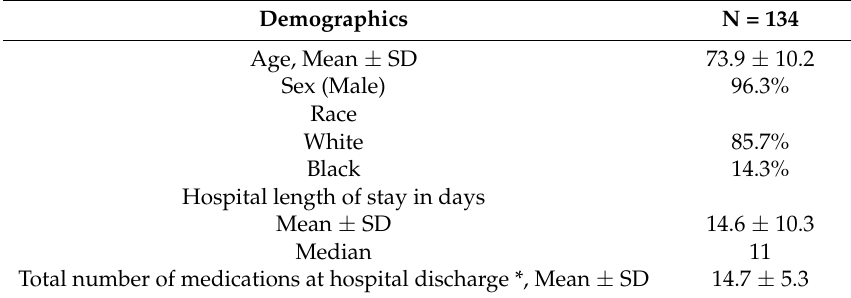
Table 1. Patient characteristics.